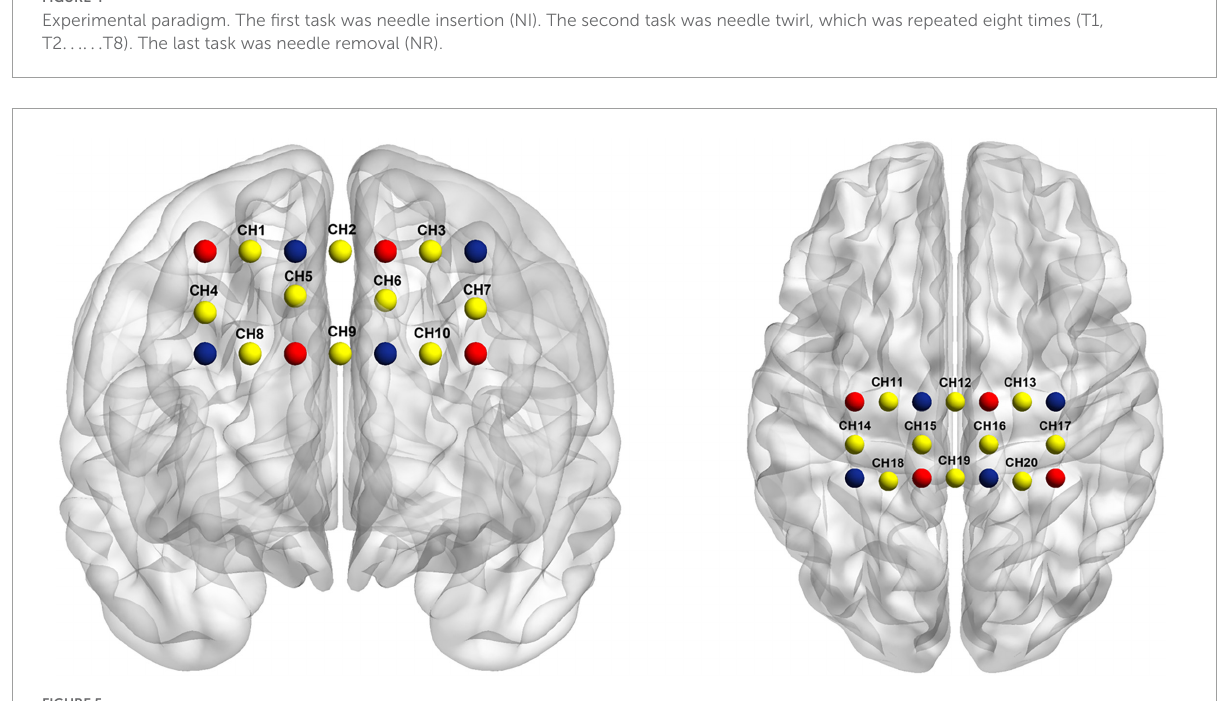
selected based on head circumference (Okamoto et al.,